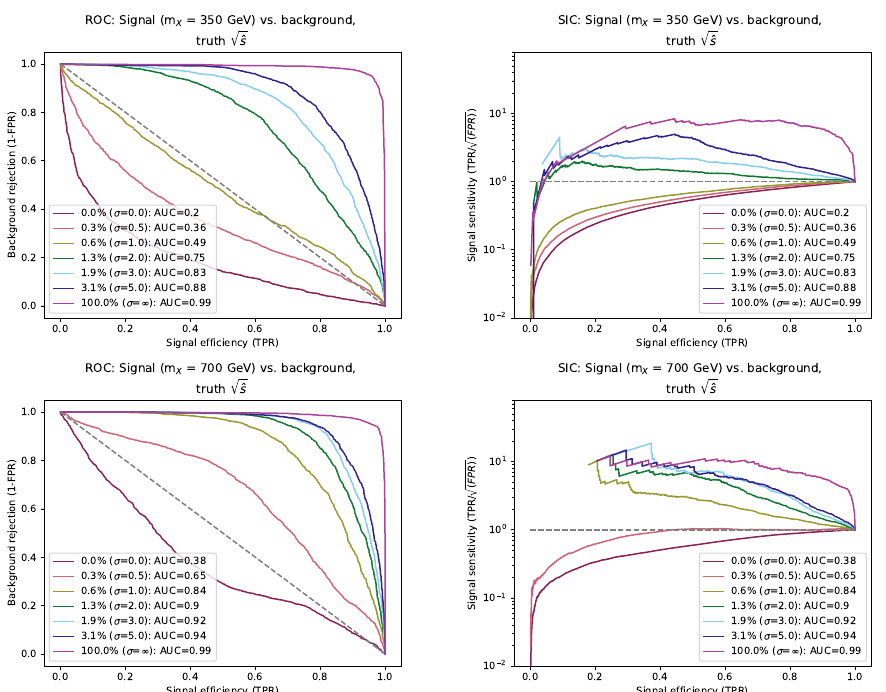
Figure 5. Semi-supervised training results in the form of ROC (left) and SIC (right) curves for two signals, m = 350 GeV (top) and m = 700 GeV (bottom) vs. background. The dashed grey line X X indicates no improvement from the use of the neural network score. A significance of ∞ indicates the case of pure signal versus pure